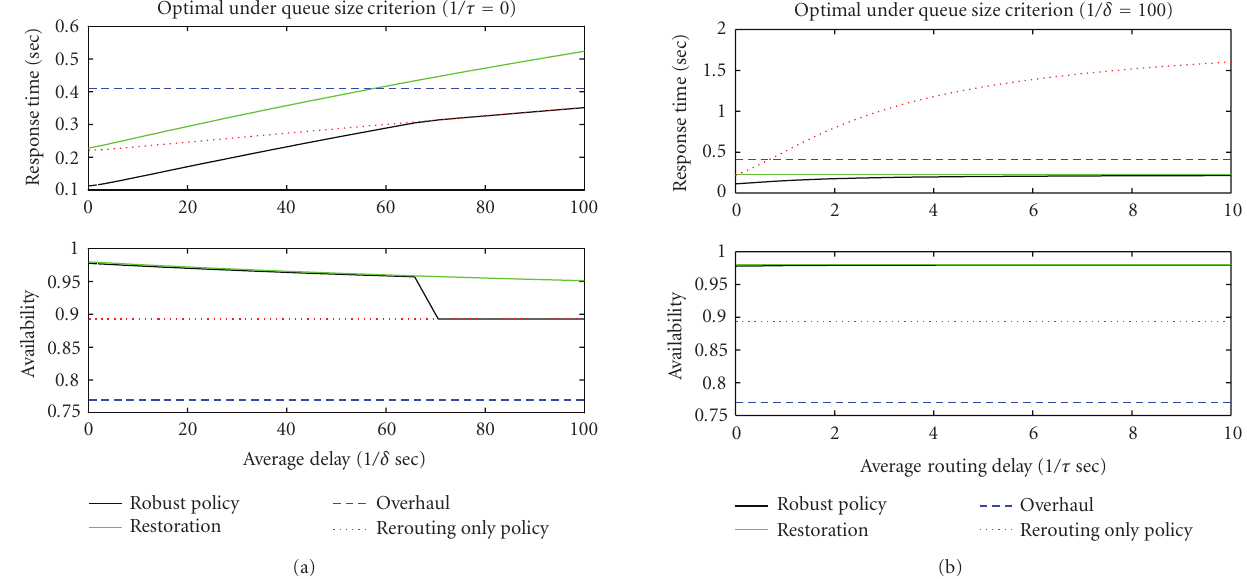
Figure 11: Response time (upper panel) and availability (lower panel) resulting from robust control policy (solid black) and routing only policy (dotted red) versus (a) control delay (1 /δ ) and (b) routing delay (1 /τ ) .